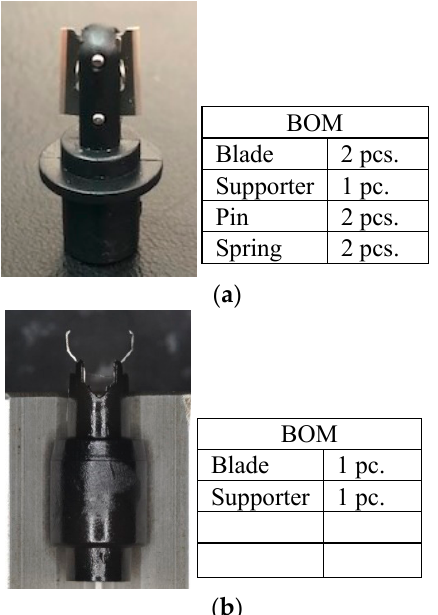
Figure 4. Comparison of inner blade sets. ( a ) Typical inner blade set in market; ( b ) Innovative inner blade set.